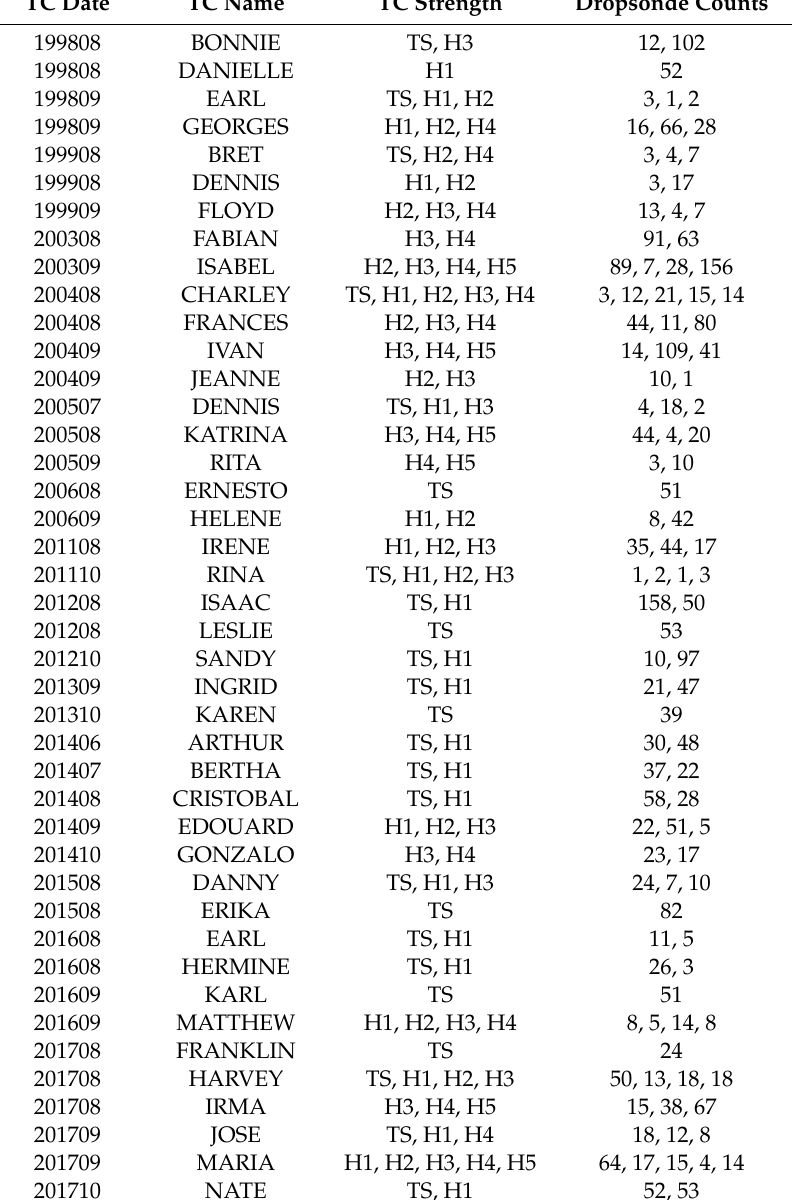
Table 1. List of TCs and number of dropsondes. Date is in year and month format. For TC strength, TS represents tropical storm; H1, H2, H3, H4, and H5 represents Category 1, 2, 3, 4, and 5 hurricanes,